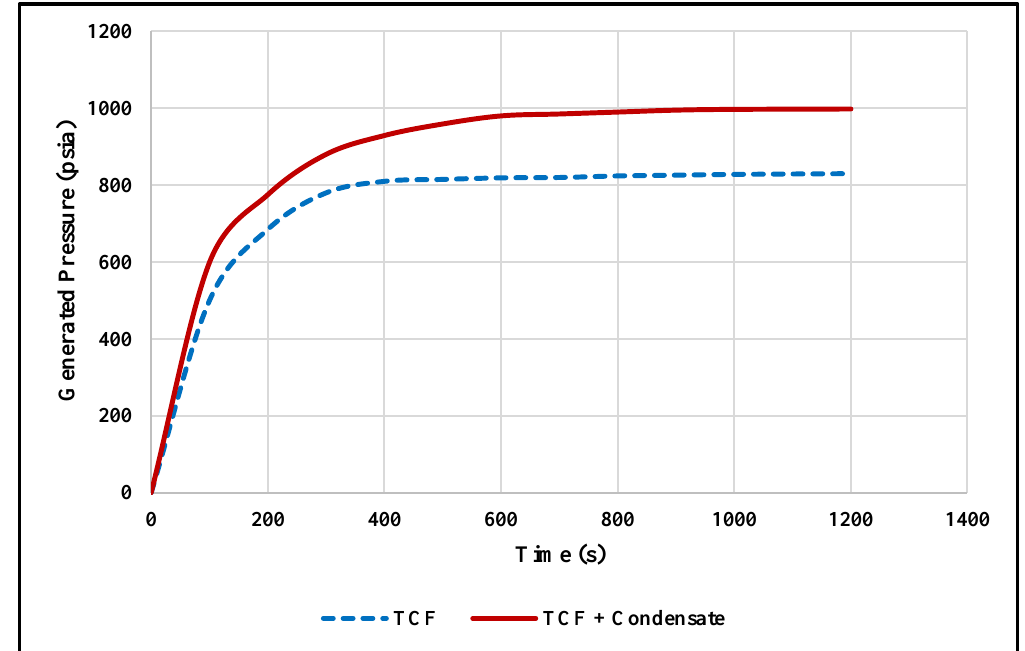
Figure 5. Temperature profiles for pure thermochemical-fluid (TCF) and TCF-condensate system.